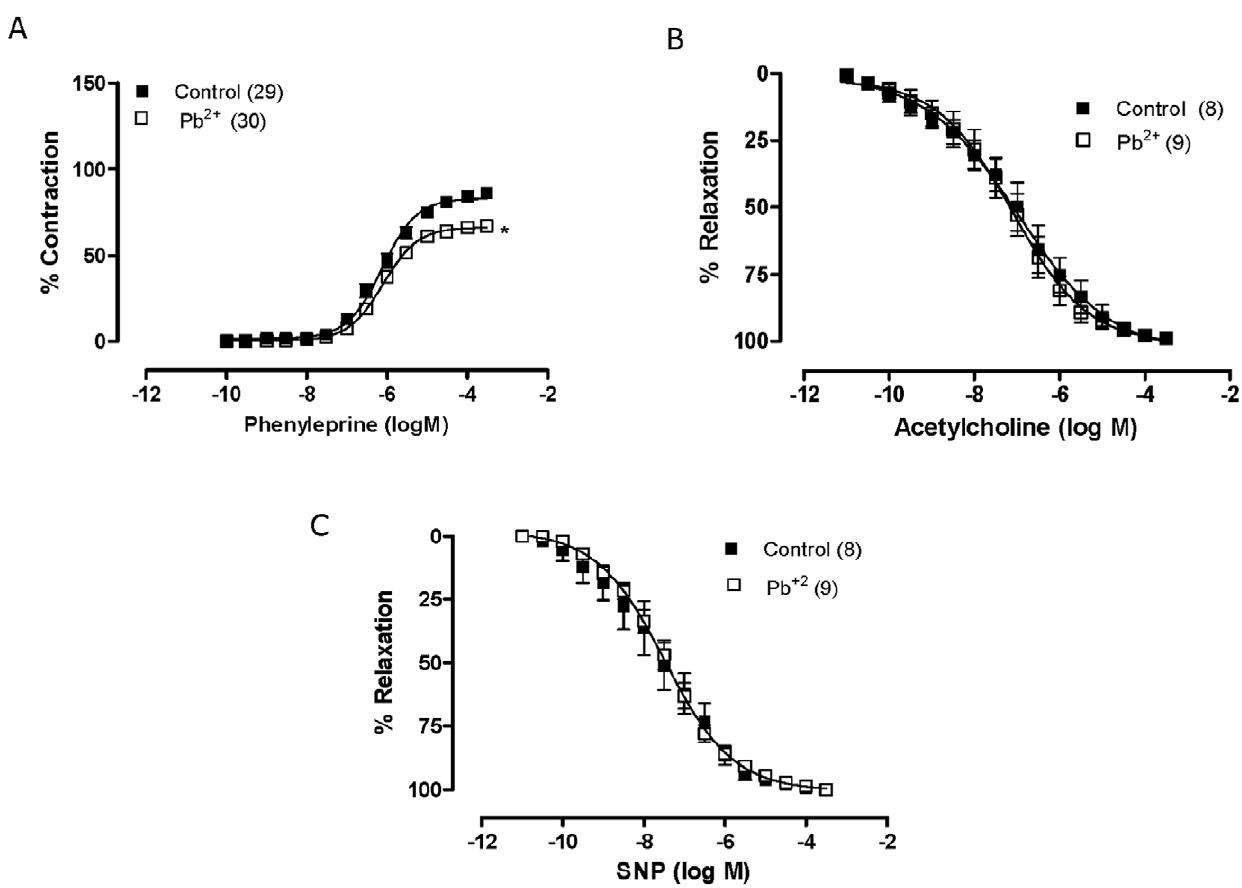
Figure 1. The effects of seven-day exposure to lead acetate on the concentration-response curves to phenylephrine (A), acetylcholine (B) and sodium nitroprusside (NSP; C) treatment in aortic rings. *P , 0.05 by Student’s t- test. Number of animals used is indicated in parentheses.